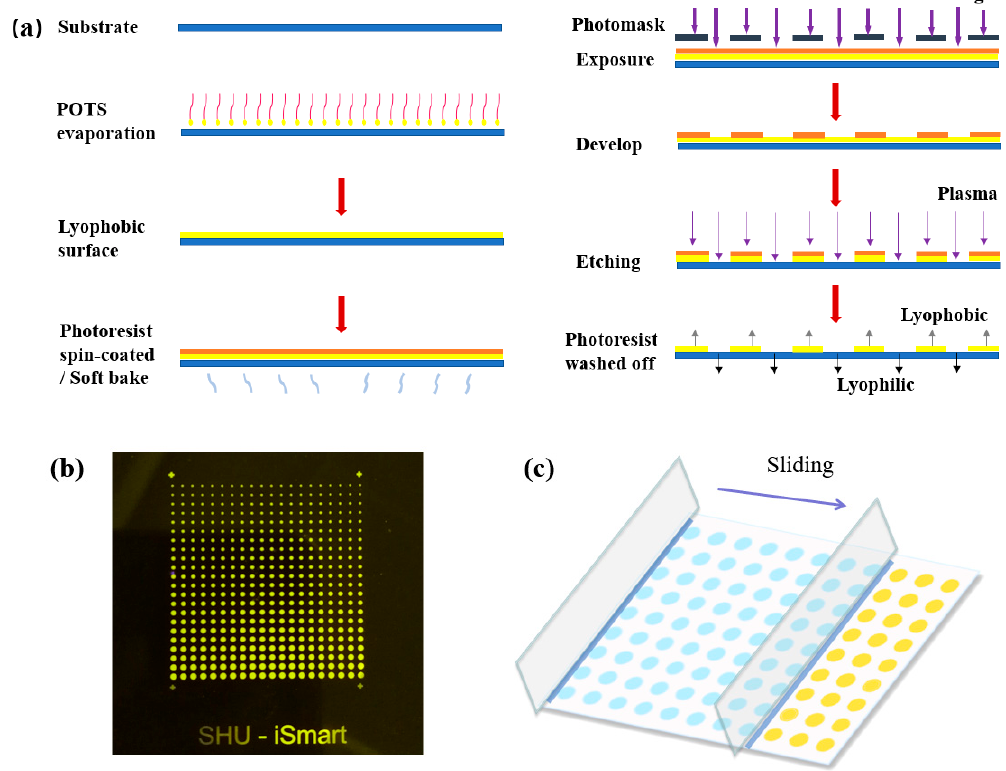
Figure 1. ( a ) Schematic illustration of the process followed to fabricate high-throughput surface-tension-confined microarrays. ( b ) Picture of lithographic mask with a spot gradient from 200 µm to 700 µm. ( c ) Schematic illustration of the sliding process, which forms the droplet array by sliding a liquid strip on the patterned substrate.